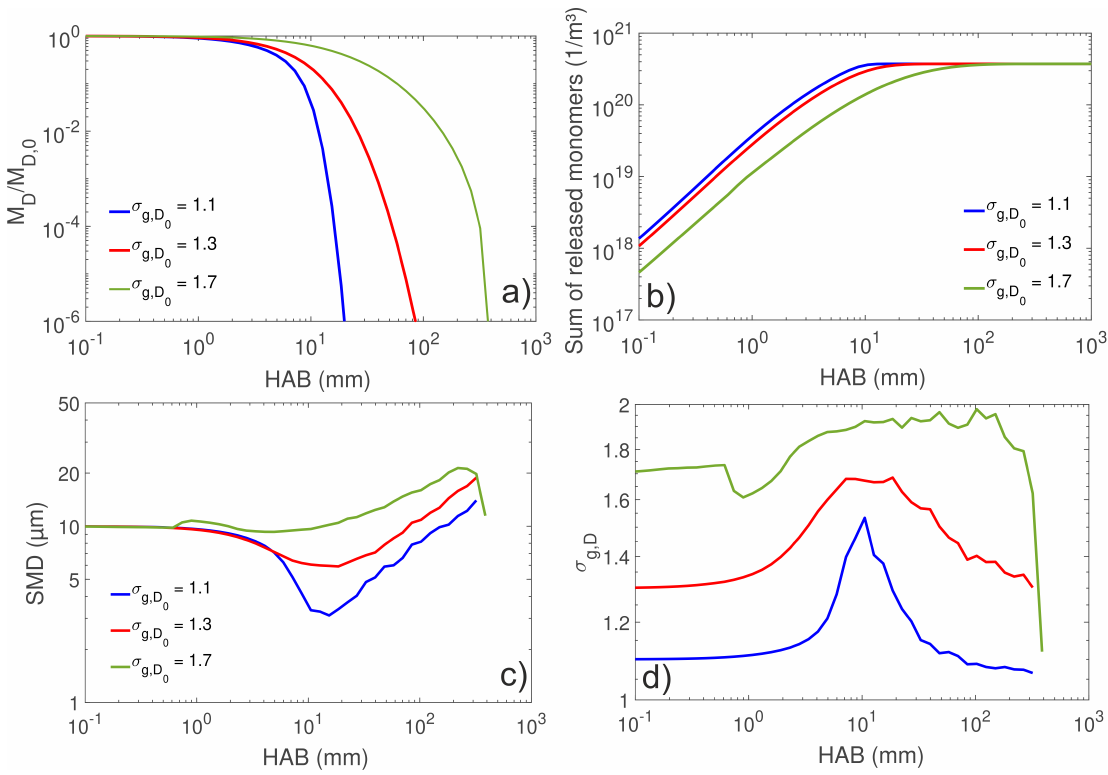
Figure 9. Effect of transient heating on the size evolution of the DSD with an initial d g,D = 1.3. σ g,D 0